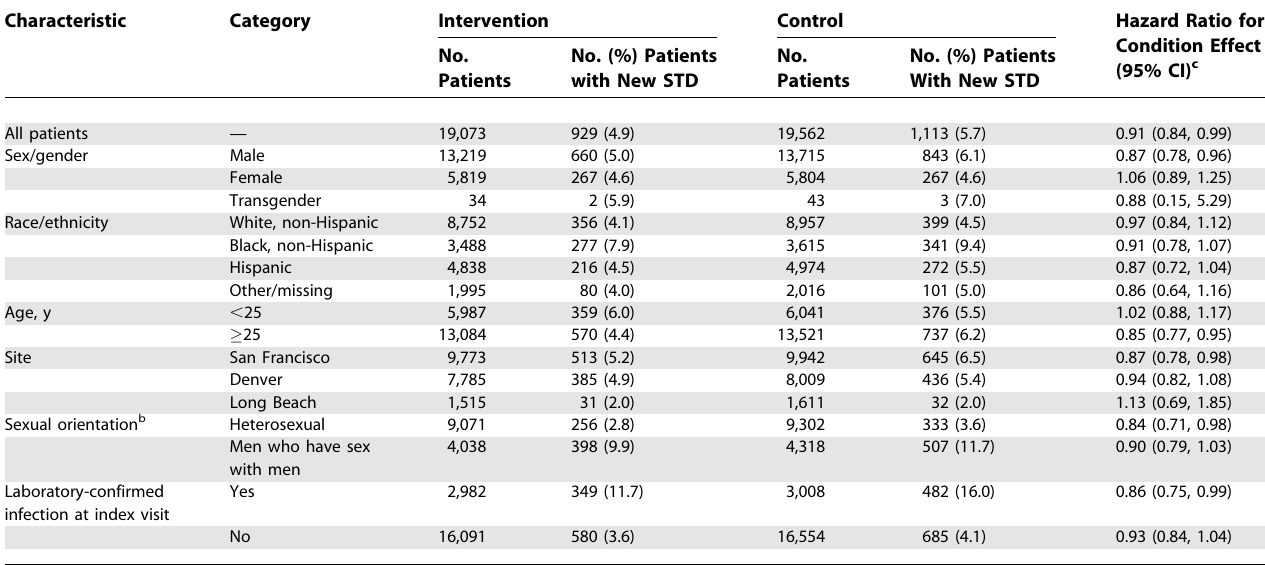
Table 2. Association Between Intervention Exposure and Diagnosis of Incident Laboratory-confirmed Infection a among Patients at STD Clinics in Three U.S. Cities, December 2003–August 2005, by Selected Patient Characteristics